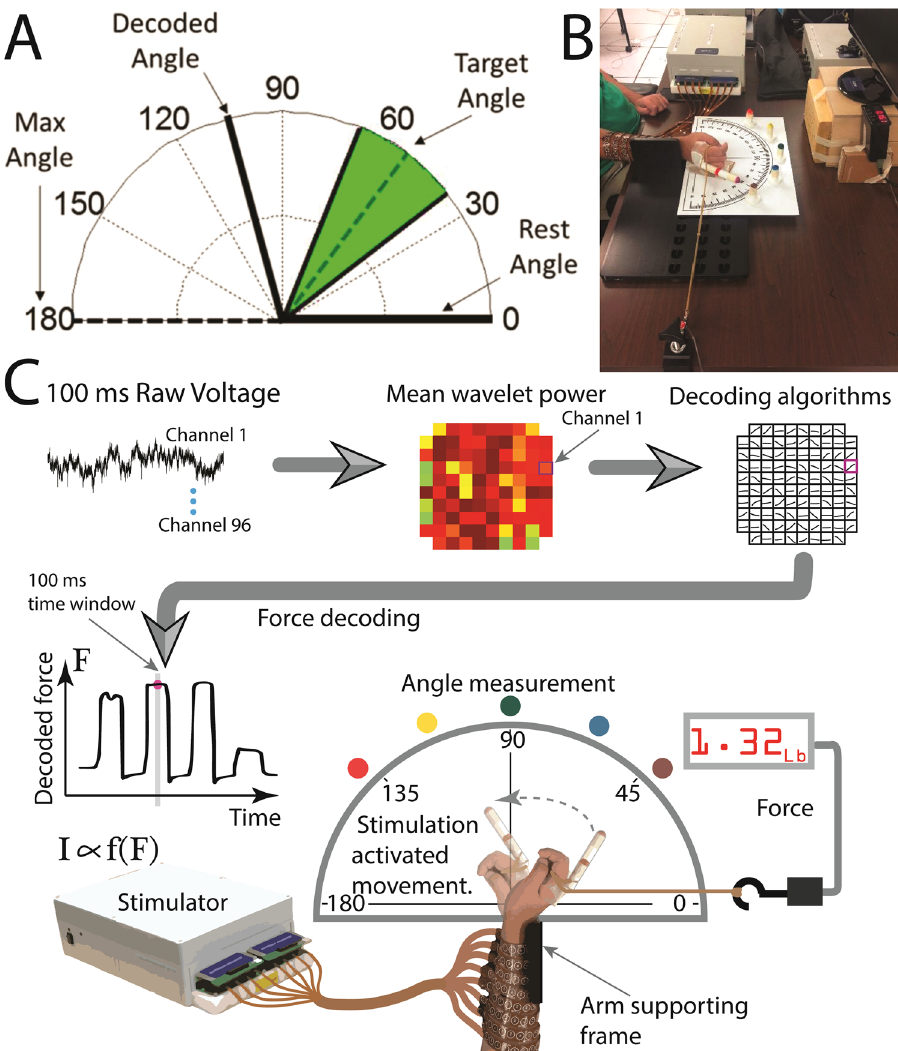
Figure 1. Decoding graded muscle contraction from intracortical activity to control participant’s wrist movement using FES. ( A ) An example screen used for the virtual graded muscle contraction experiment. Potential angles that can be cued range from 0° to 180°. A target angle is cued with a 15° window on either side of the angle (green) and the thick black line tracks the angle decoded from the participant’s modulation in real- time. ( B ) Photograph of the graded control of muscle contraction experiment using the BCI-FES system. ( C ) Flow chart detailing the graded control of muscle contraction experiment where intracortically recorded voltage data are converted to MWP features which are then fed into a decoding algorithm which outputs decoded force, F. The decoded force is then translated into a set of stimulation parameters, I, and the resulting wrist flexion movement is recorded by the load cell and an overhead